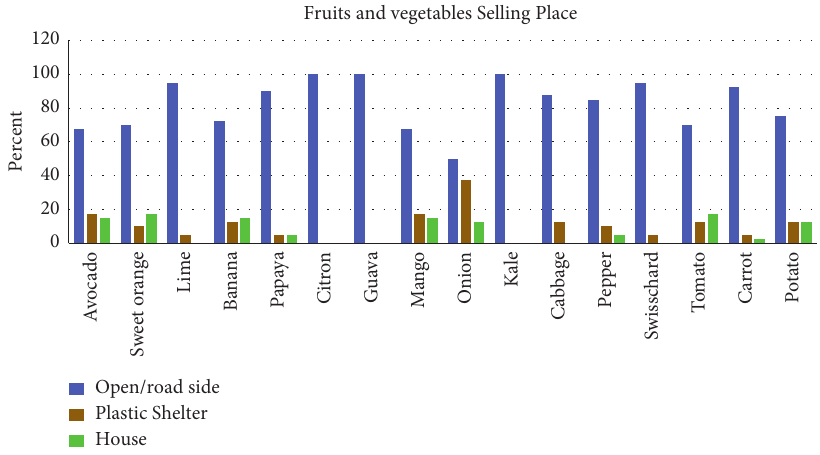
Figure 4: The percentage of selling fruits and vegetables at a market, n � 40. Table 4: Fruits and vegetables storage methods and storing